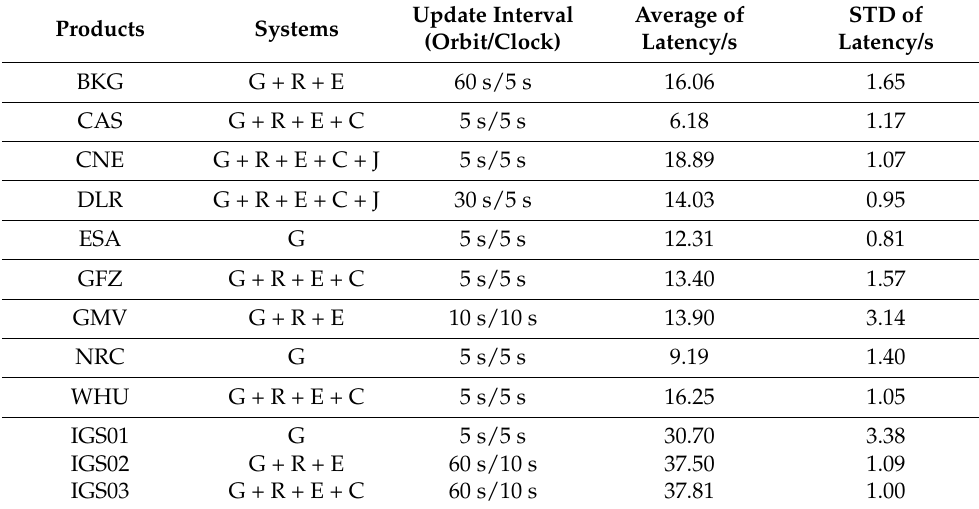
Table 1. RTCM-SSR mount points